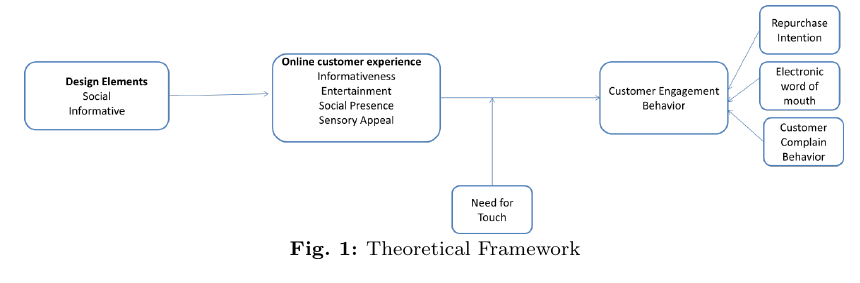
Fig. 1: Theoretical